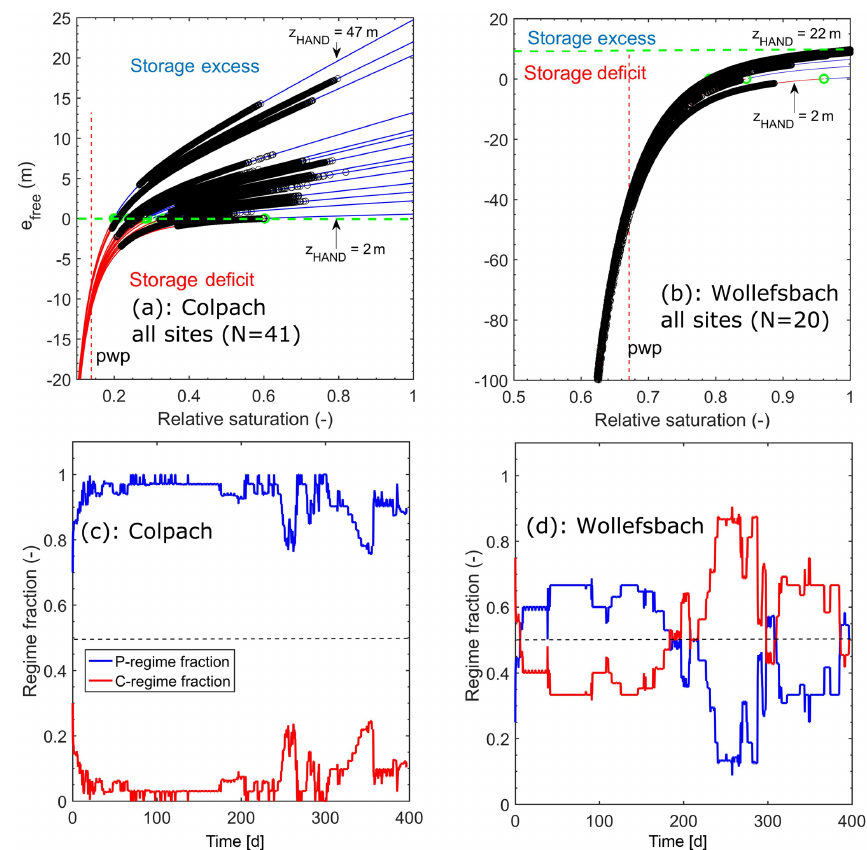
Figure 7. Free energy of all observations in the Colpach (a) and Wollefsbach (b) plotted in their corresponding energy state function (note the different scales). The black circles mark the observations. The horizontal green lines mark the equilibrium of zero free energy. (c) and (d) show which fractions of the data set were in the P- or C-regime as a function of time. Note that the corresponding distributions of HAND are shown in Fig. 3b and